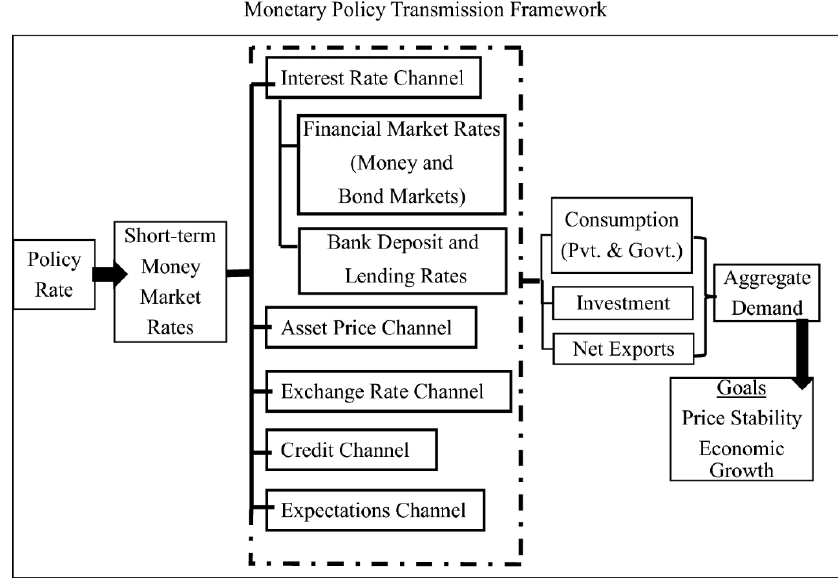
Fig. 1 Fund flow process of bank financial